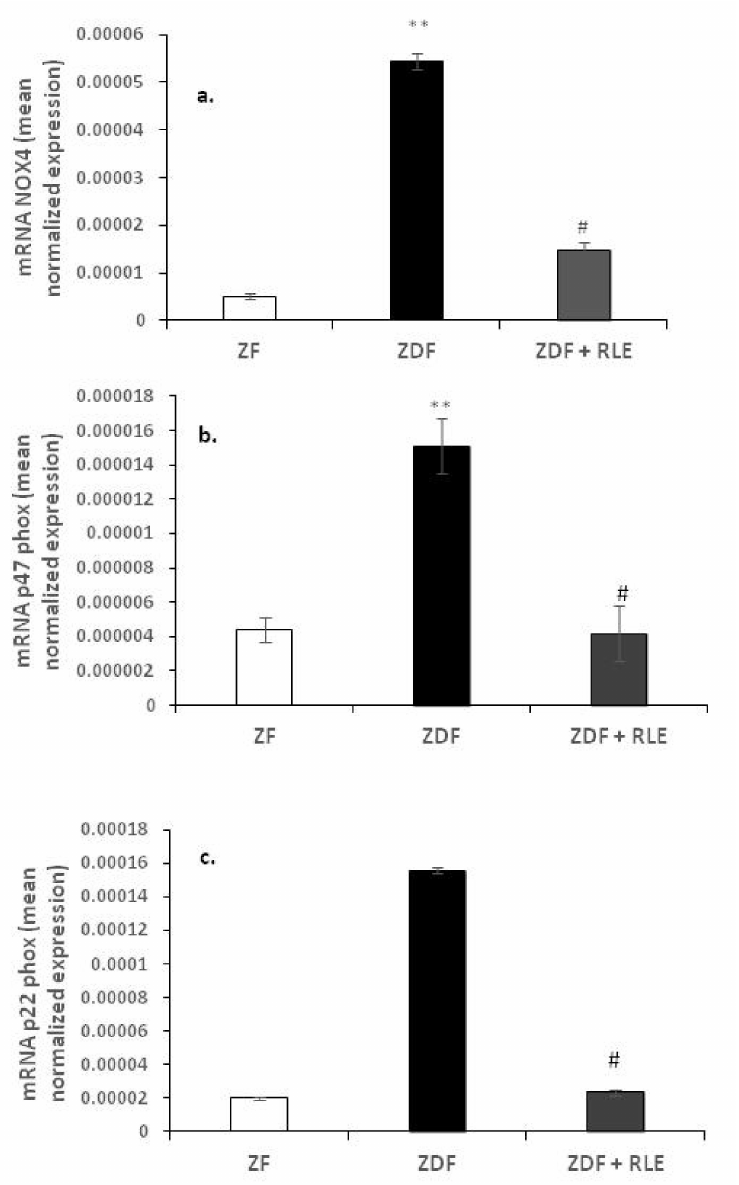
Figure 1. NOX4, p22-phox and p47-phox expression in Zucker Fatty (ZF), Zucker Diabetic Fatty (ZDF), and Zucker Diabetic Fatty + red orange and lemon extract (ZDF + RLE), after 24 weeks of treatment. ( a ) mRNA levels of NOX4 in ZF, ZDF, and ZDF + RLE; ( b ) mRNA levels of p47-phox in ZF, ZDF, and ZDF + RLE; and ( c ) mRNA levels of p22-phox in ZF, ZDF, and ZDF + RLE. Experiments were conducted in triplicates, and values are presented as mean normalized expression (MNE) normalized towards 18S expression (mean ± standard error) (** p < 0.01 versus ZF; # p < 0.05 versus